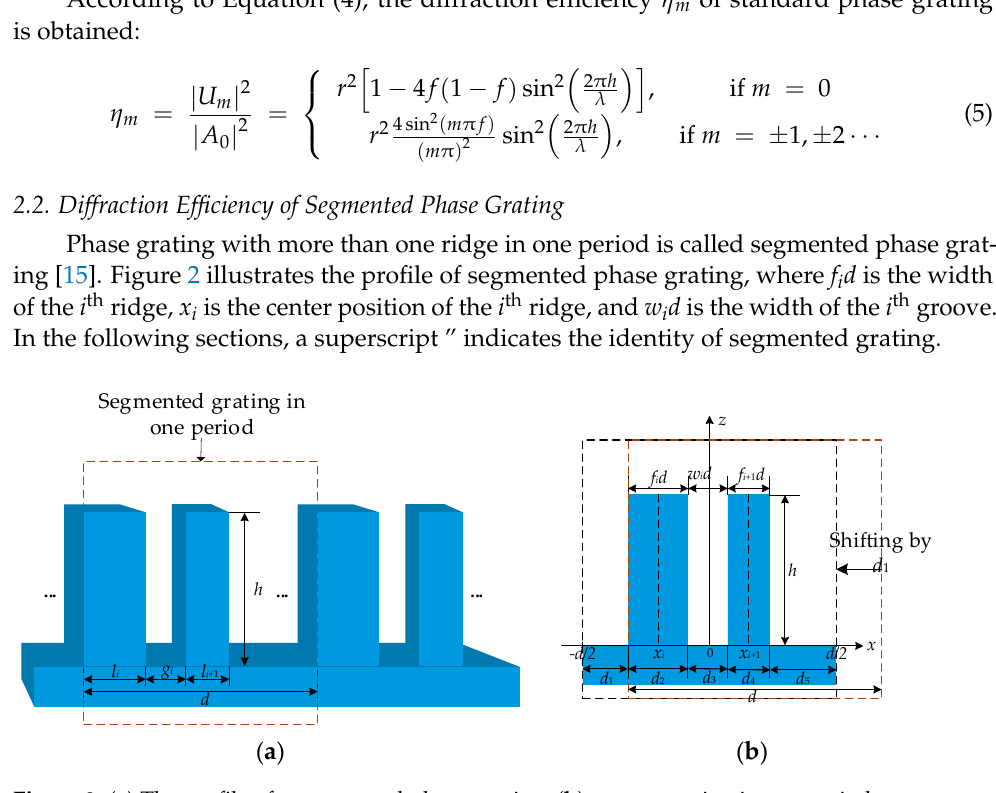
Figure 2. ( a ) The profile of a segmented phase grating; ( b ) a cross-section in one period. When the segmented phase grating contains two ridges in one period, the length